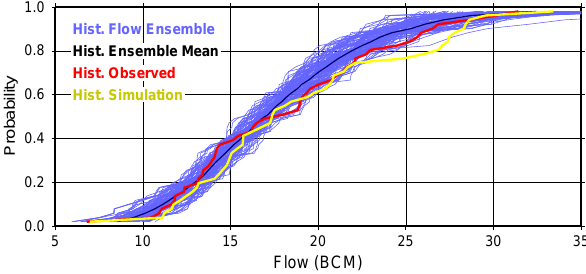
Fig. 5. ECDFs of downscaled simulated flows on the Colorado River at Lees Ferry, AZ, 1950 through 1999, compared with ob- served and historical simulated flows.